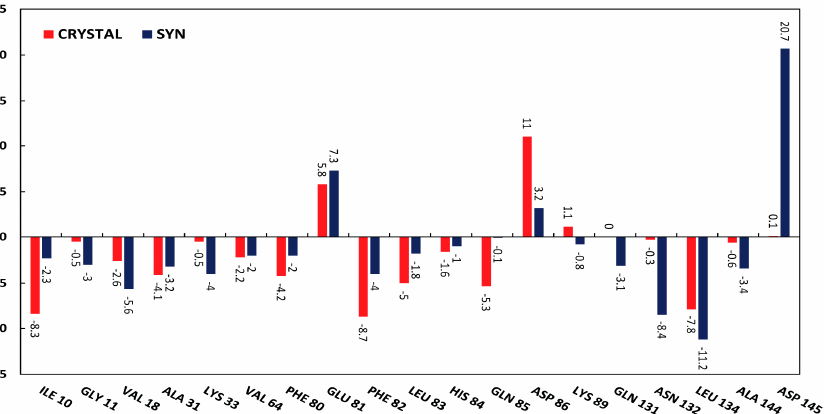
Figure 6. Comparison of interacting amino acid residues of the ATP binding site of CDK2 (PDB ID 1FVT) with HI 5 syn -isomer ( Syn ) and co-crystallized ligand (Crystal). Thirteen amino acids with a difference in energy values more than ~2 times were